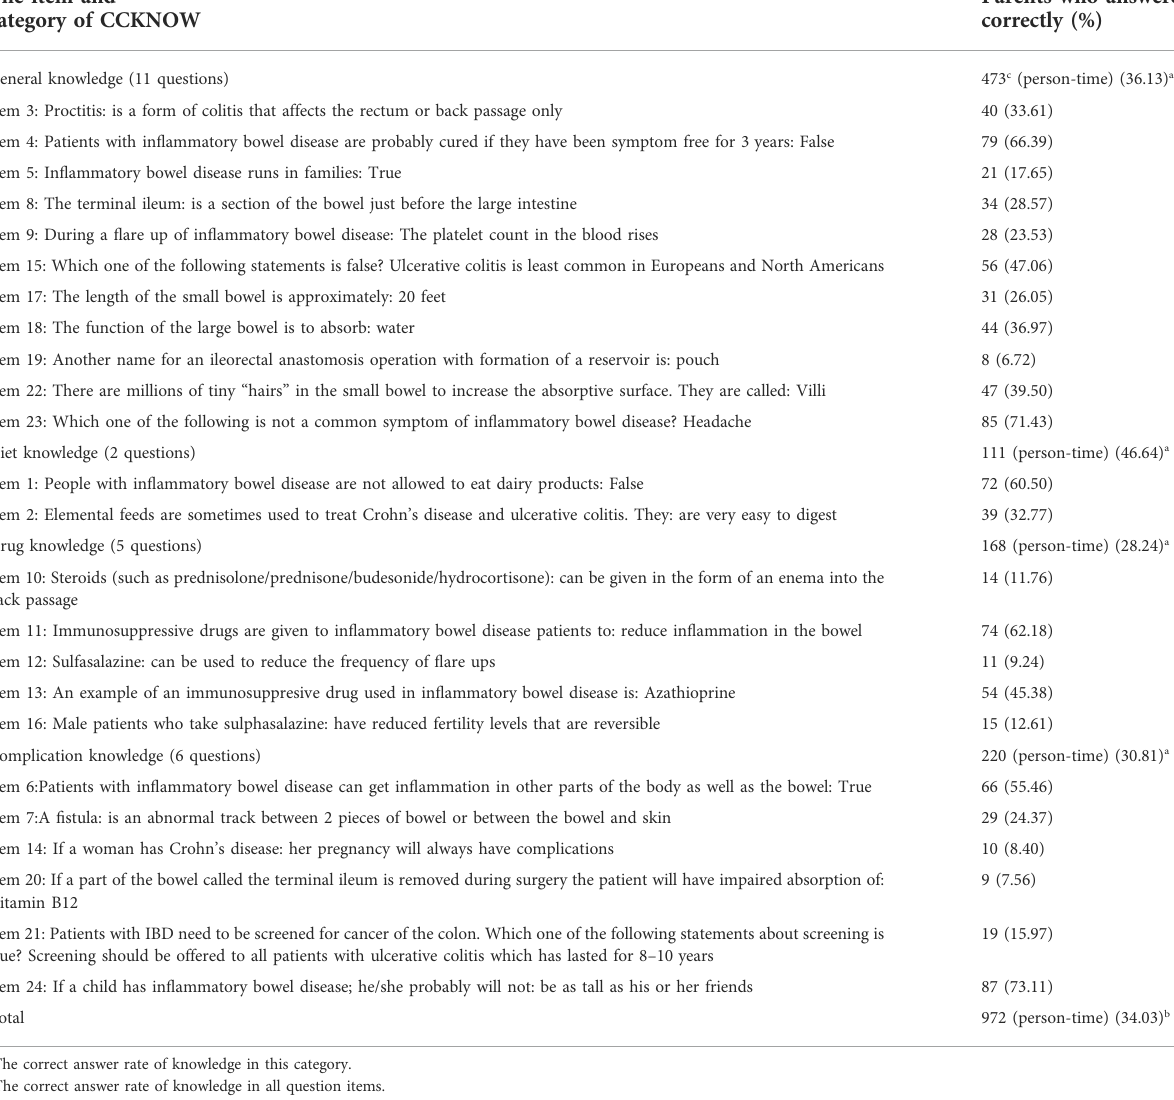
TABLE 4 The correct answer rate for the overall level of CCKNOW and for each item and